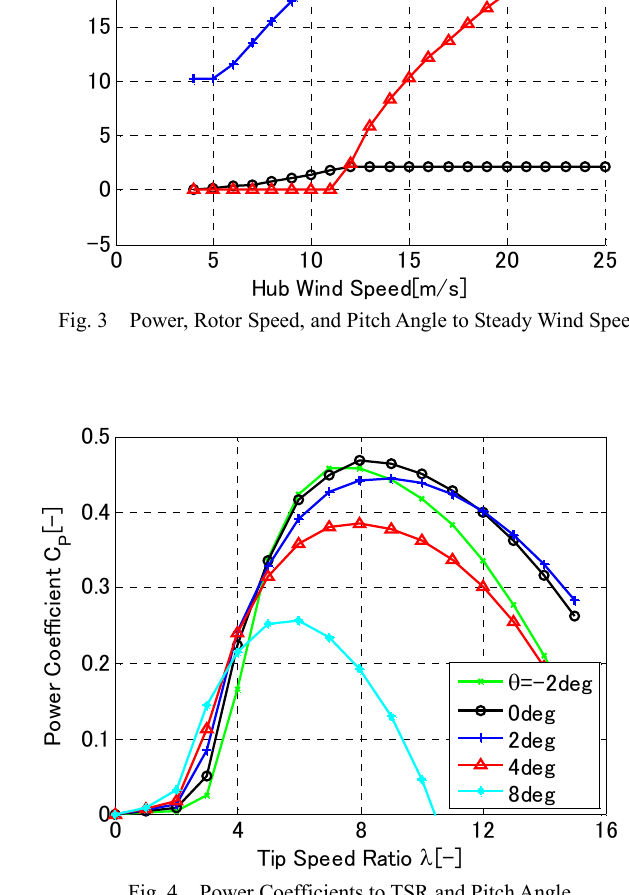
Fig. 4 Power Coefficients to TSR and Pitch